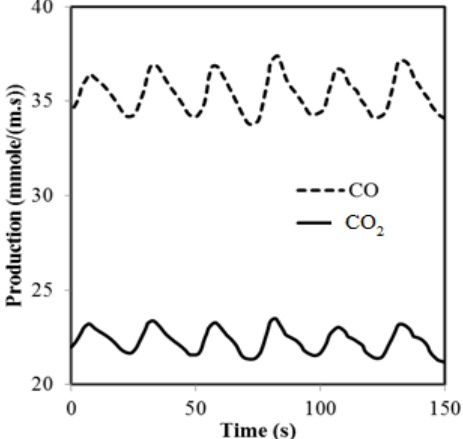
Figure 32. Production of CO and CO 2 as function of time for κ = 0.12 m − 1 and an oxygen injection rate of 47 mmole m − 1 s − 1 [60].